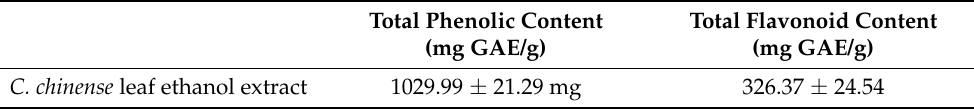
Table 1. Total phenolic and total flavonoid contents of C. chinense leaf ethanol